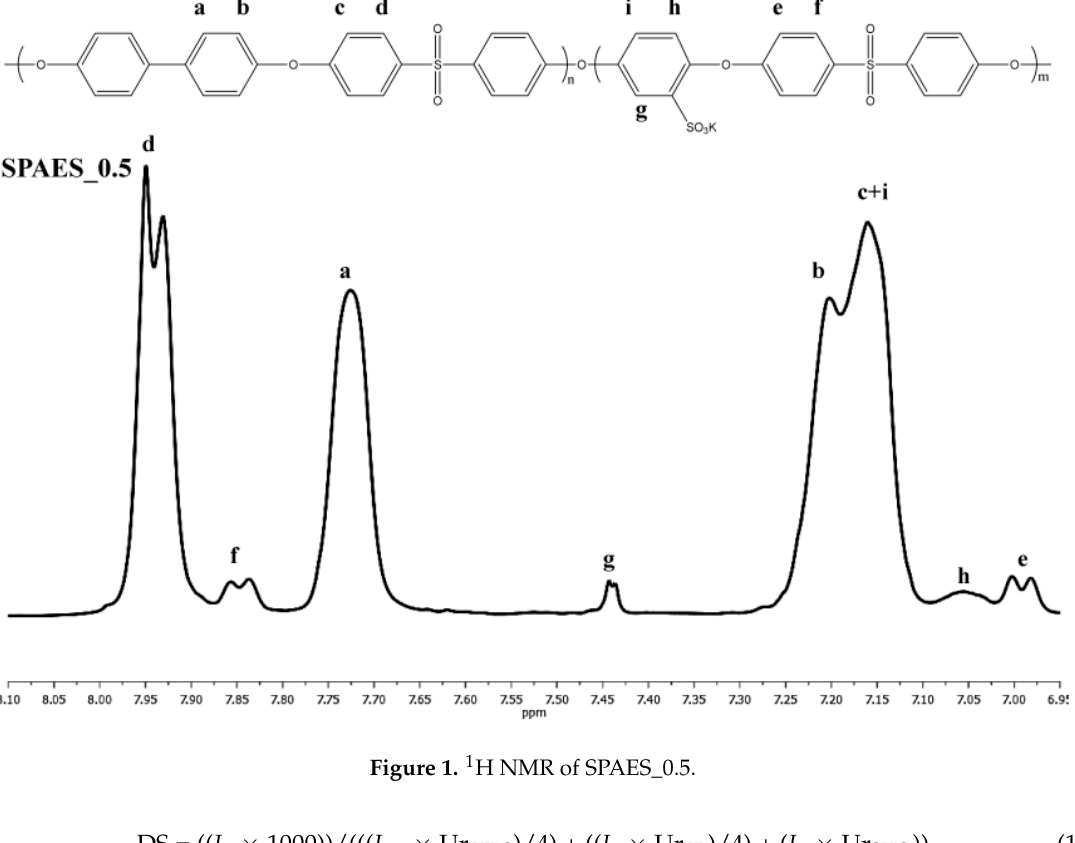
Figure 1. 1 H NMR of SPAES_0.5.